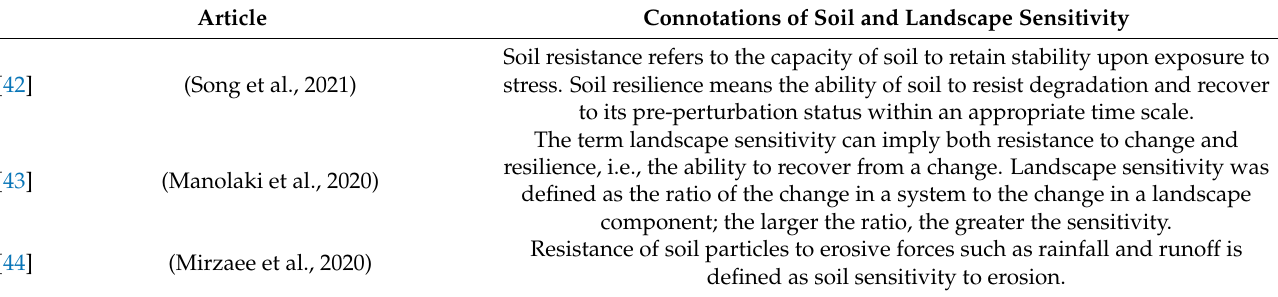
Table 5. Connotations of “soil and landscape sensitivity”, reverse chronologically